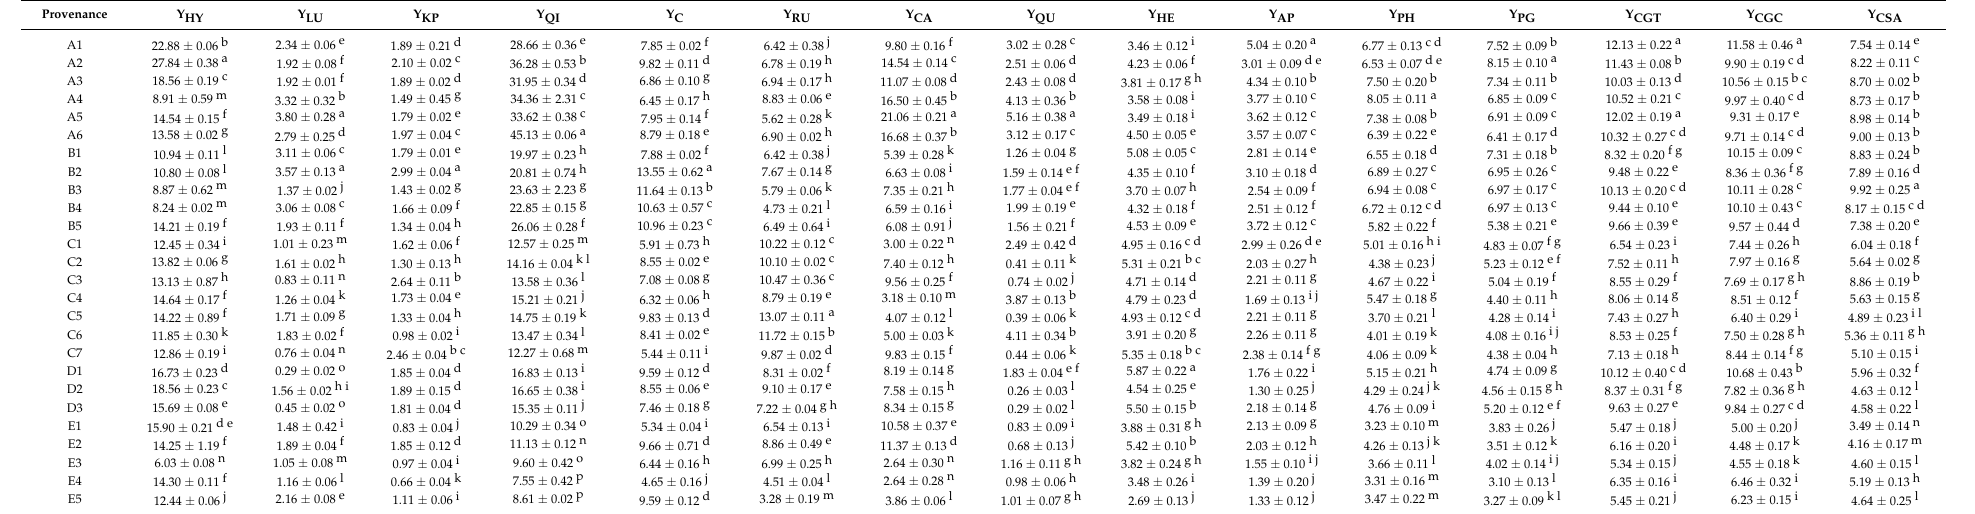
Table 1. Fifteen flavonoids content (mg/g) in different varietal types of Chinese prickly ash peels